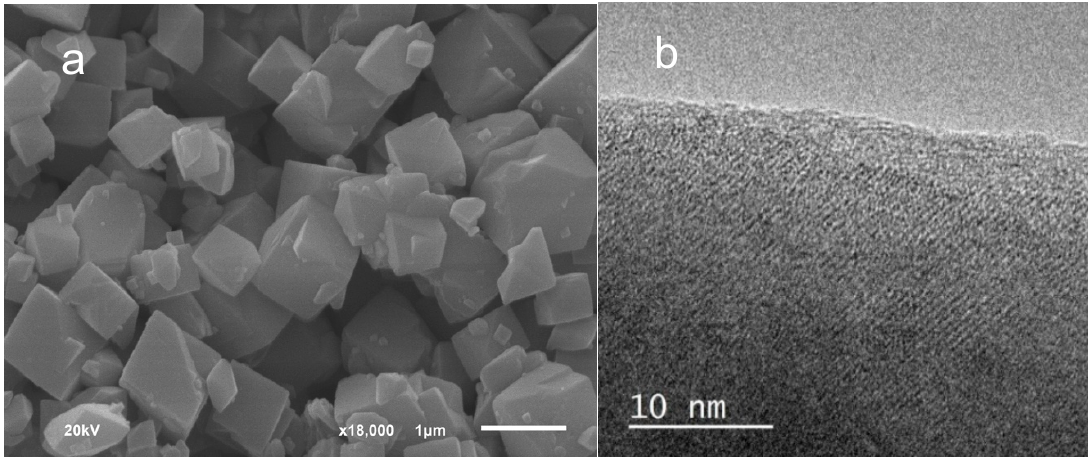
Figure 3. SEM and TEM images showing the rhombohedral shape ( a ) and the core-shell morphology of a single domain ( b ) of natrojarosite obtained by aging after 28 days (HC-28d).